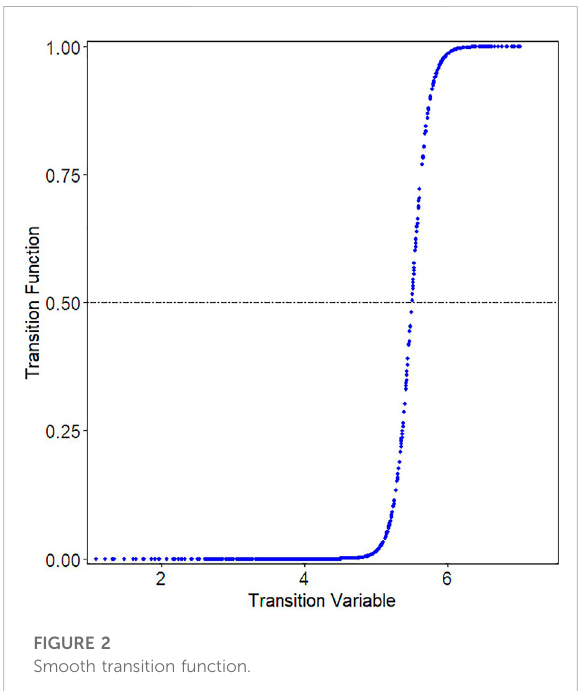
TABLE 8 Results of the PSTR estimation.